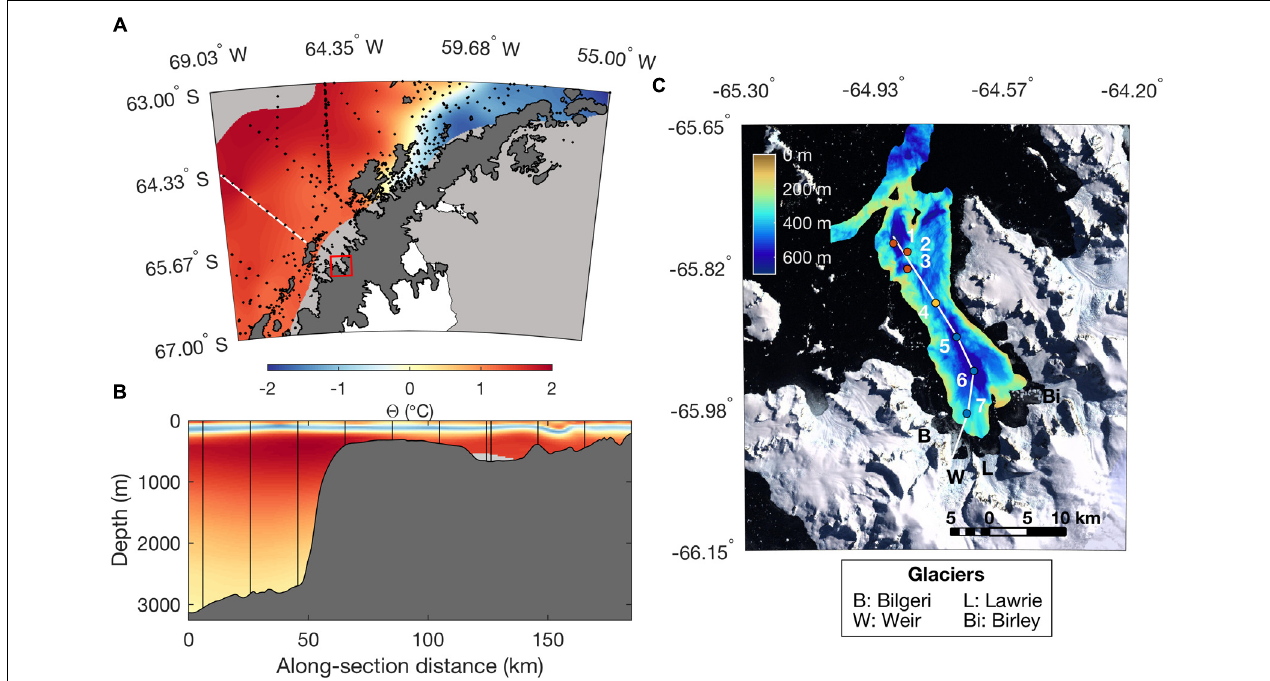
FIGURE 1 | Map of the study area depicting (A) the Antarctic Peninsula. Black points correspond to hydrographic stations contained in the World Ocean Database. Color shading depicts ocean temperature along the σ θ = 27.75 kg m − 3 isopycnal, corresponding to the core of the mUCDW layer on the WAP continental shelf. The white line, corresponding to the 500-line of the Palmer LTER grid, indicates the cross-shelf section shown in (B) , and the red box indicates the location of Barilari Bay, shown in (C) . The Antarctic coastline is derived from MOA2009 (Haran et al., 2014). (B) Cross-shelf section of temperature along the line shown in (A) . Black vertical lines indicate the location of hydrographic stations. Bathymetry is indicated by dark gray shading. (C) Landsat image of Barilari Bay from the Landsat Image Mosaic of Antarctica (Bindschadler et al., 2008), showing location of occupied hydrographic stations. Stations are color-coded by location for references in the remaining figures, including reference stations (red), mouth (yellow), and inner fjord (blue). Colored shading indicates processed bathymetry collected during NPB1001. Letters indicate the location of marine-terminating glaciers flowing into Barilari Bay, and the white line the along-fjord section shown in Figure 3